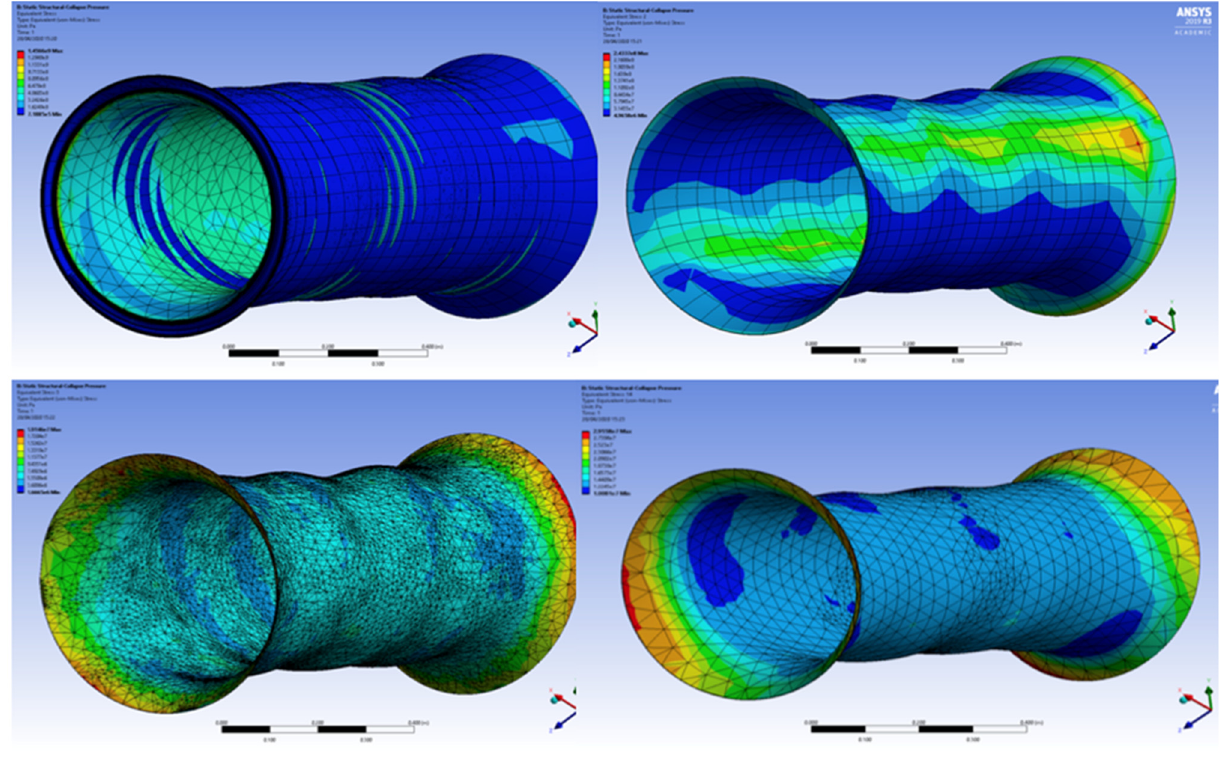
Figure 19. Collapse loading of different layers under extreme conditions, for equivalent von Mises stress on 4 different layers of the marine hose (under 0.5× magnification, and the ends are without end fitting or additional reinforced ends) .